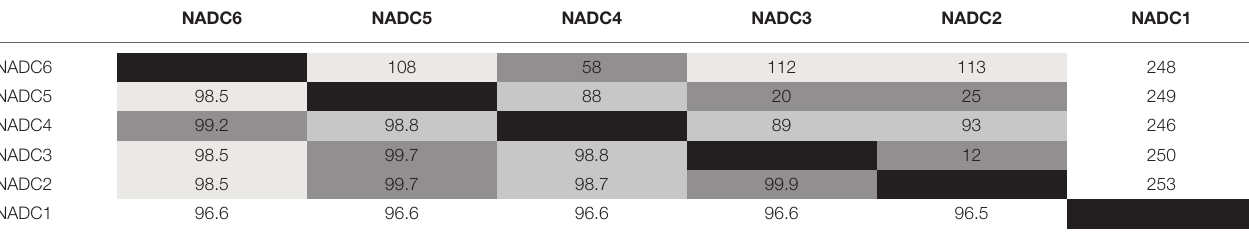
TABLE 2 | Complete genome sequence distance matrix and heat map for the six sequenced SVA